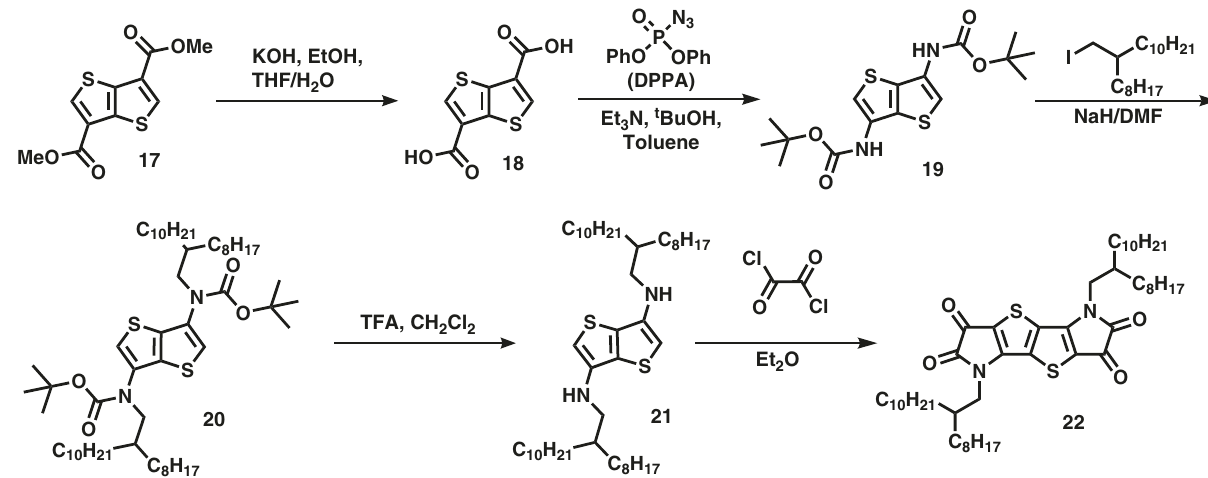
Fig. 3 Synthesis of thieno[3,2-b]thiophene bis-isatin monomer. The monomer was synthesised in fi ve steps from dimethyl thieno[3,2-b]thiophene-3,6- dicarboxylate. This synthesis makes use of a Curtius rearrangement reaction to introduce a Boc protected amine to avoid a thieno[3,2-b]thiophene-3,6- diamine intermediate due to their instability Table 1 Polymer molecular weight, ionisation energies, electron af fi nities, optical properties and thin fi lm